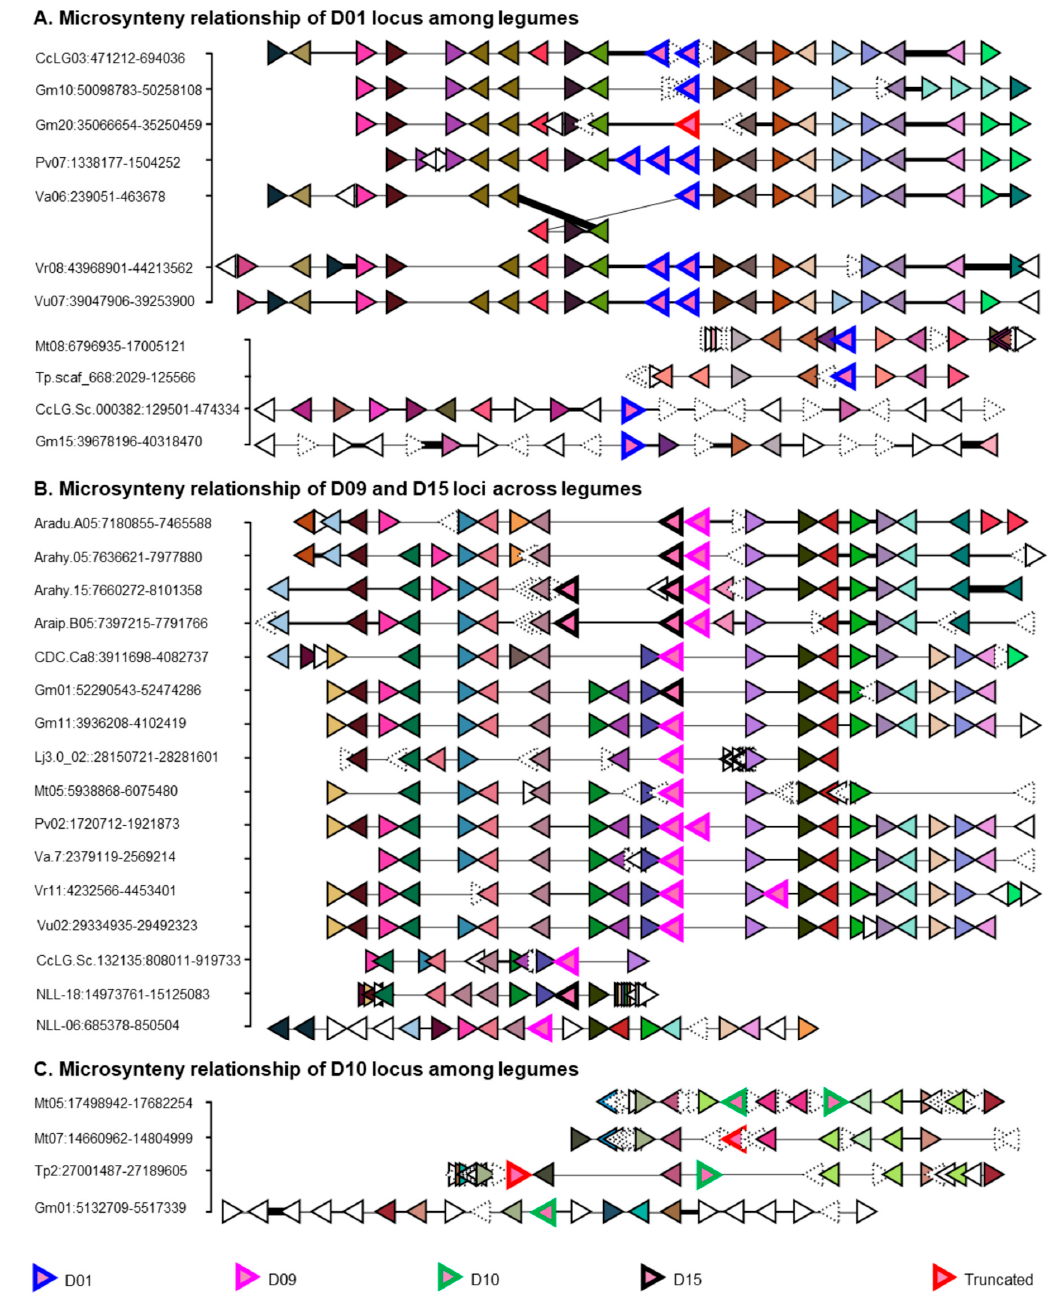
Figure 5. Microsynteny relationship of putative ortholog loci (POL) D01, D09, D10, and D15 in F5 14 legumes. ( A ). Microsyntenic genome segments having D01 locus are retrieved and centered using Phvul.007G020600 (first panel) and Medtr8g044140 (second panel). ( B ). Microsyntenic genome segments having D09 and D15 loci are retrieved and centered using Phvul.002G016400. ( C ). Microsyntenic genome segments having D10 locus are retrieved and centered using tripr.gene37002 (Tp57577_TGAC_v2_mRNA38240). A–C, Orthologous / paralogous gene pairs are indicated through use of a common color. Uncolored and distorted genes are singletons and orphans respectively in these genome regions. Species and genomic positions are mentioned in the left side of each